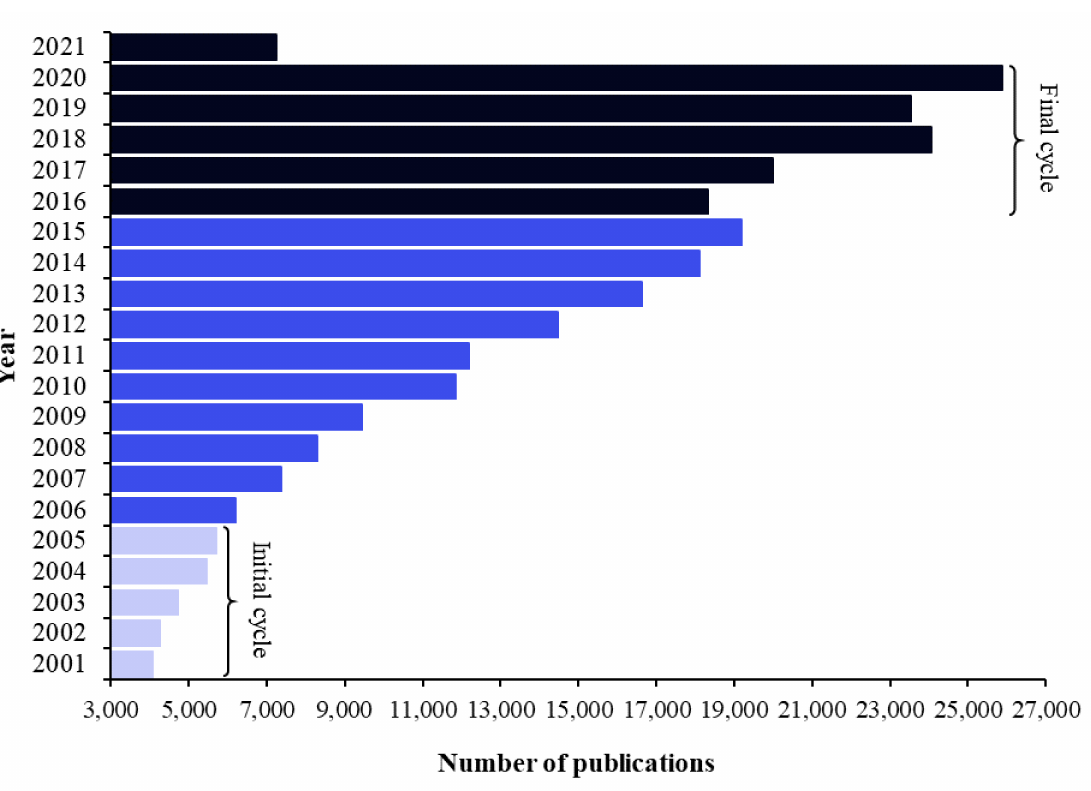
Figure 1. Annual number of scientific publications identified in the CAPES database. The search strategy was (“essential oil” OR extract) AND antib*.